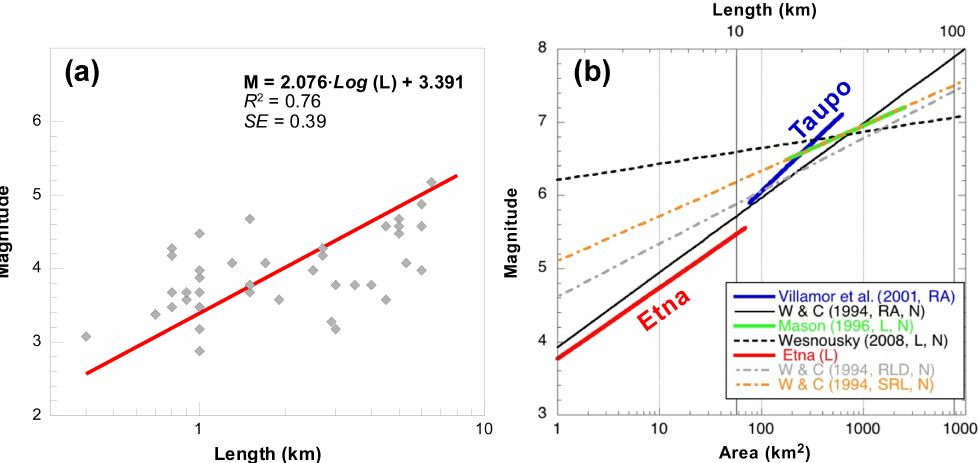
Figure 10. (a) Plot of earthquake magnitude vs. rupture length for the Etna region (this study); (b) comparison with the magnitude–size scaling relationships for the Taupo volcanic zone (Villamor et al., 2001) and other relationships worldwide (Wells and Coppersmith, 1994; Mason, 1996; Wesnousky, 2008). Abbreviations: L is fault length; N is normal kinematics; RA is rupture area; RLD is rupture length at depth; SRL is surface rupture